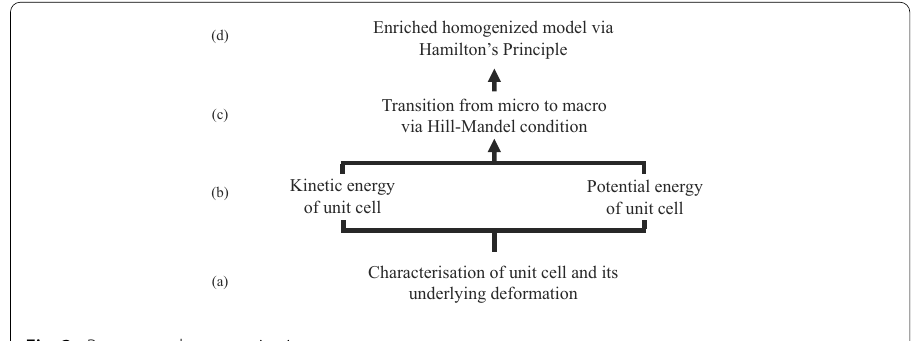
Fig. 3 Bottom-up homogenization